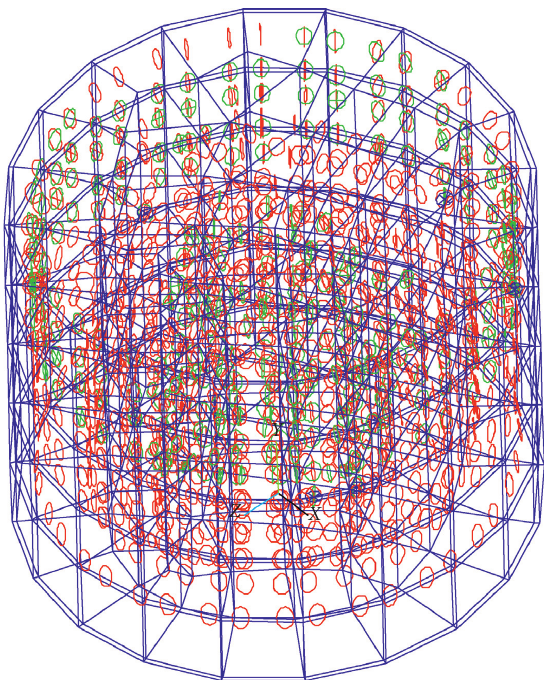
Figure 24: Spherical hinge cracking diagram 3.